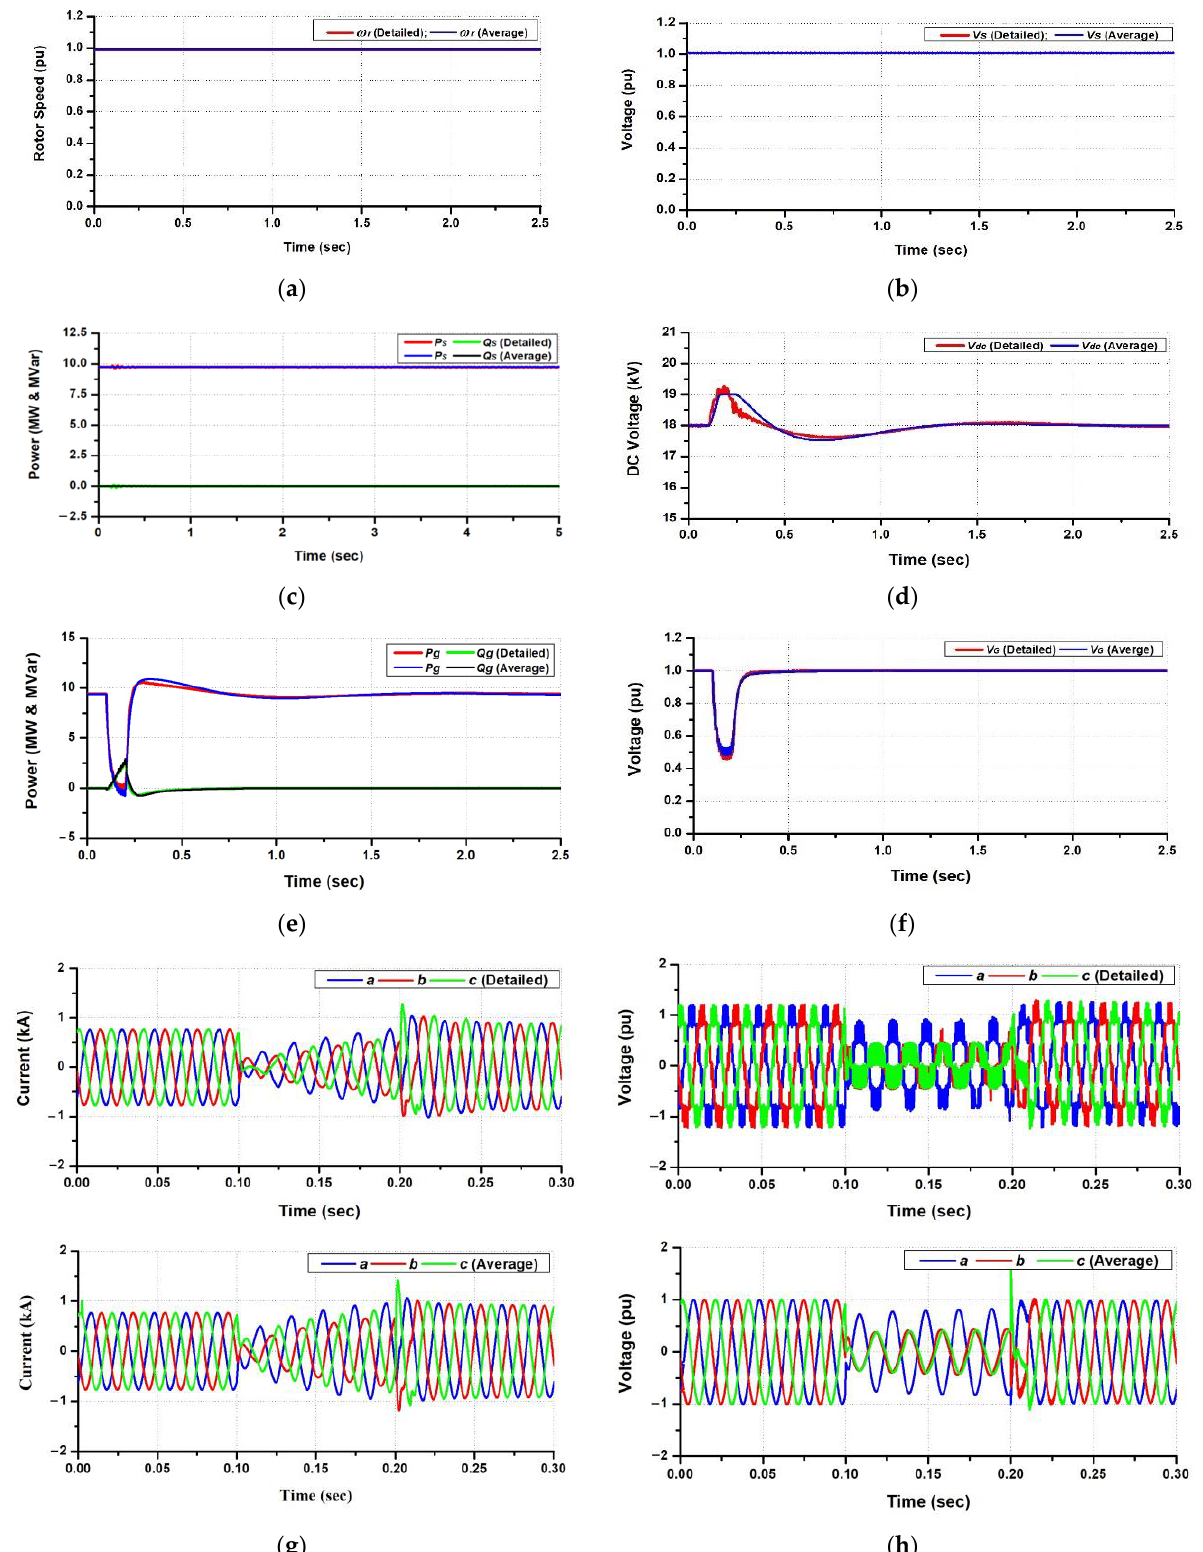
Figure 22. Dynamic Performances of WTG1 in the case of 2LG: ( a ) Rotor speed response; ( b ) Voltage profiles at the terminal of the stator winding; ( c ) Active and reactive power output of the PMSG; ( d ) DC link circuit voltage profile; ( e ) Active and reactive power output of grid-side MMC; ( f ) Voltage profile at Bus BG1; ( g ) Waveform of current at the grid-side MMC; ( h ) Waveform of voltage at the grid-side MMC.